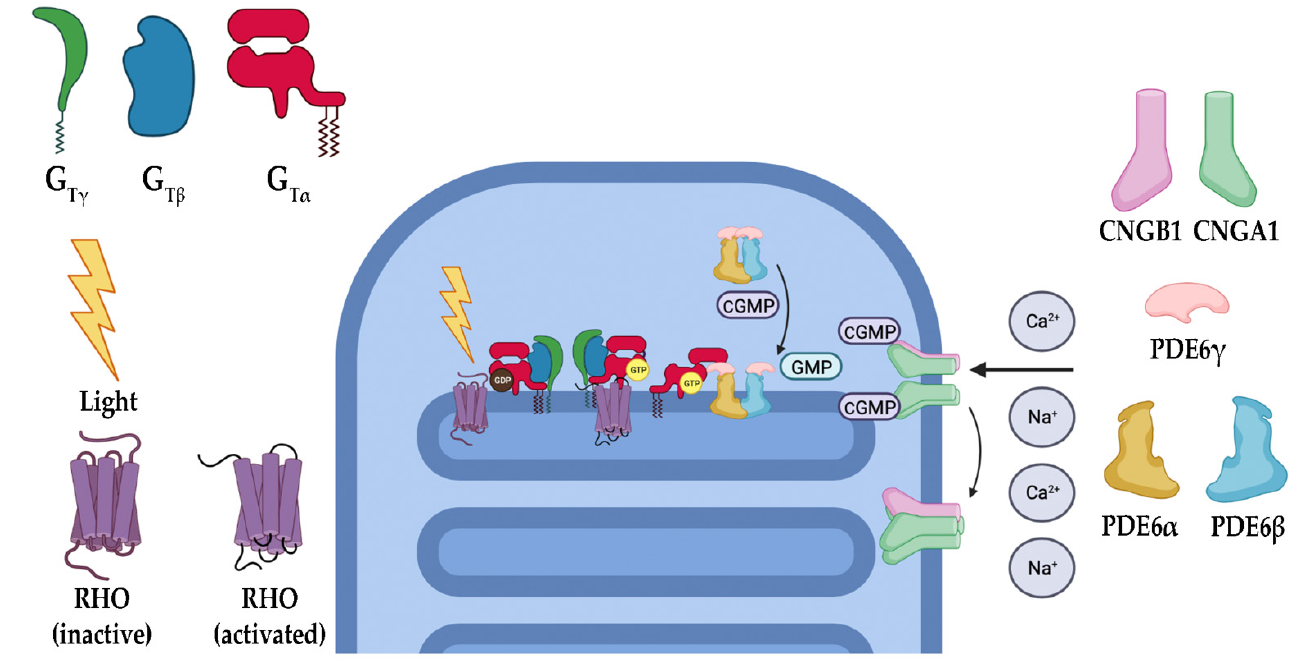
Figure 2. Diagram of phototransduction activation pathway proteins. Upon activation of RHO by absorption of a photon of light by its chromophore 11- cis retinal, RHO shifts its helical structure to allow for activation of the G-protein transducin (G T ). G T , composed of α , β , and γ subunits, exchanges a GTP for a GDP in its activation site, allowing for separation of the α subunit from the βγ subunit complex, which then goes to activate the PDE6 enzyme by releasing the inhibition of its γ subunit. PDE6 then hydrolyzes cGMP to GMP, causing closure of the CNG channels, composed of three α and one β subunit, and subsequent hyperpolarization of the photoreceptor. This slows glutamate release at the synapse and propagates the electrical signal to the second and third-order neurons of the retina, the bipolar cells, and ganglion cells, respectively.